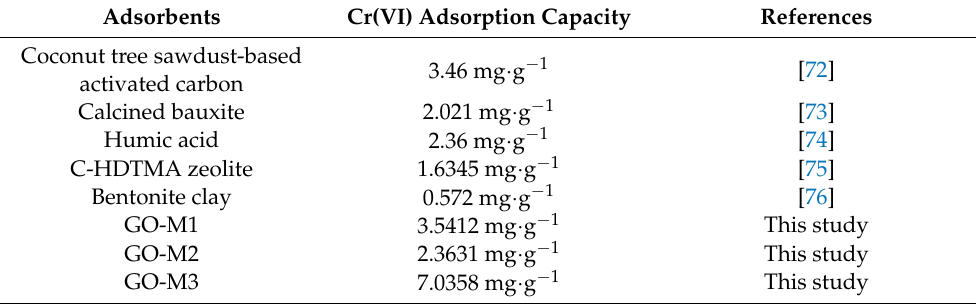
Table 8. A comparison of Cr(VI) adsorption capacity of different adsorbents with GOs.